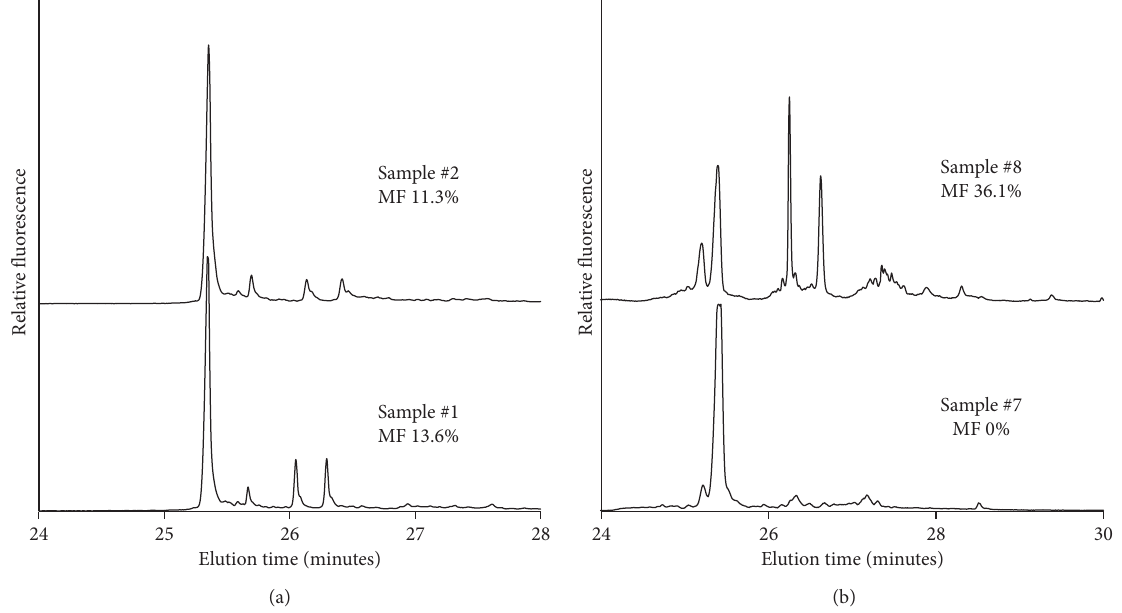
Figure 1: Electropherograms and peak separation as a result of cycling temperature capillary electrophoresis from initial tumor scan analysis. (a) Two samples representing the same prostate specimen, both demonstrating detected mtDNA mutations in prostate tumor 1. (b) Two samples representing the same prostate specimen, one of which demonstrating detected mtDNA mutations in prostate tumor